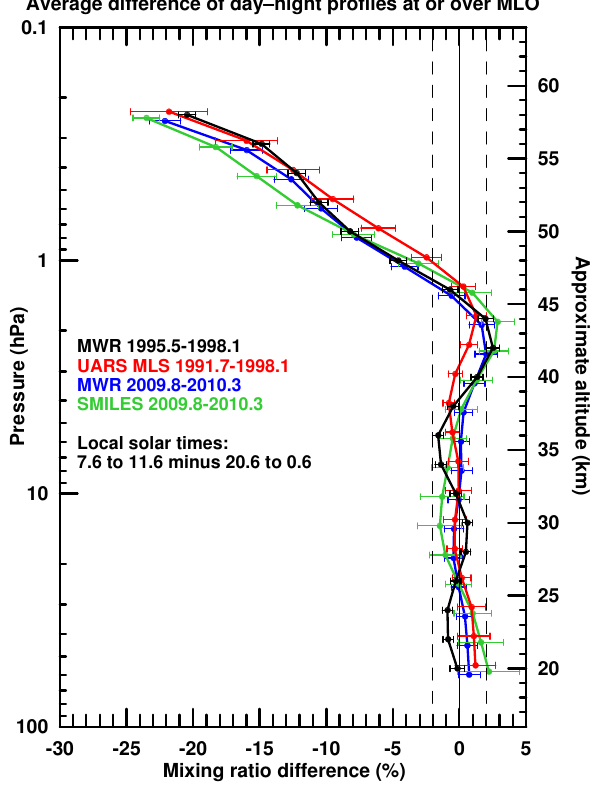
Figure 7. Percentage differences between morning and afternoon ozone profiles. The morning satellite profiles are all from NOAA- 17 SBUV/2 measurements, averaged between 09:36 and 10:36LST. The reference afternoon profiles are from NOAA-18 (red) or NOAA-16 (blue) and were averaged from 13:36 to 14:36LST. They were subtracted from the morning profiles and normalized as de- scribed in Sect. 2.1. Differences between morning and afternoon (reference) MWR measurements taken during the same time blocks are shown for comparison in black (selected data) or gray (all data). The data used for the NOAA-17 and 16 profile were averaged from July 2002 to December 2005; those for the NOAA-17 and 18 pro- file were averaged from June 2005 to November 2009. MWR data were averaged from July 2002 to December 2009. Error bars are calculated and displayed as described in the caption for Fig. 1. The SBUV/2 data have not been convolved with the MWR averaging kernels because the resolutions of the two instruments are